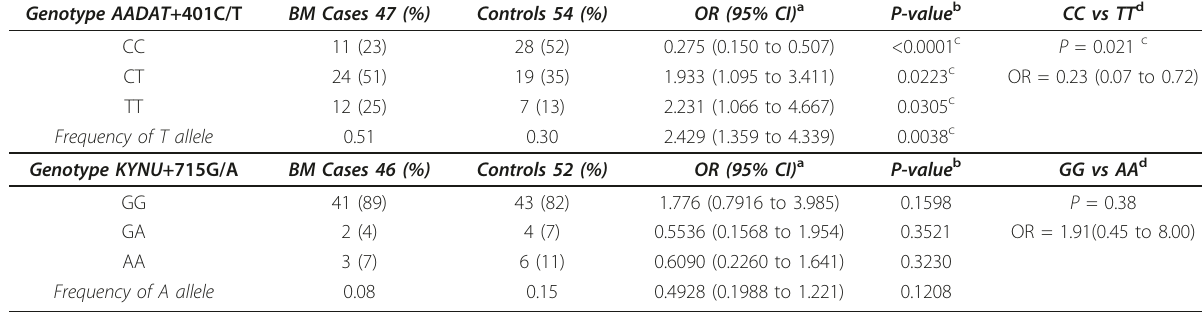
Table 2 Genotypic and allelic frequencies of SNPs AADAT +401C/T and KYNU+ 715G/A Genotype AADAT +401C/T